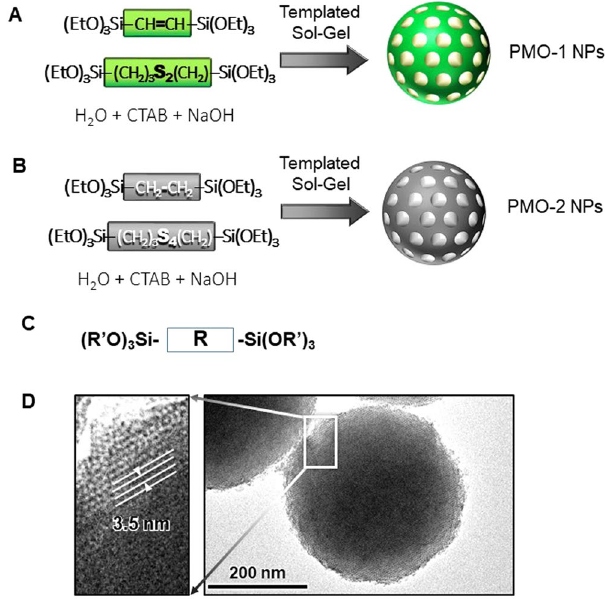
Figure 3. Biodegradable PMO nanoparticles used in the study. PMO-1 contains disulfide bonds ( A ) and PMO-2 contains tetrasulfide bonds ( B ). ( C ) A general structure of precursor molecules used for the synthesis. ( D ) TEM picture of PMO-2 nanoparticle.